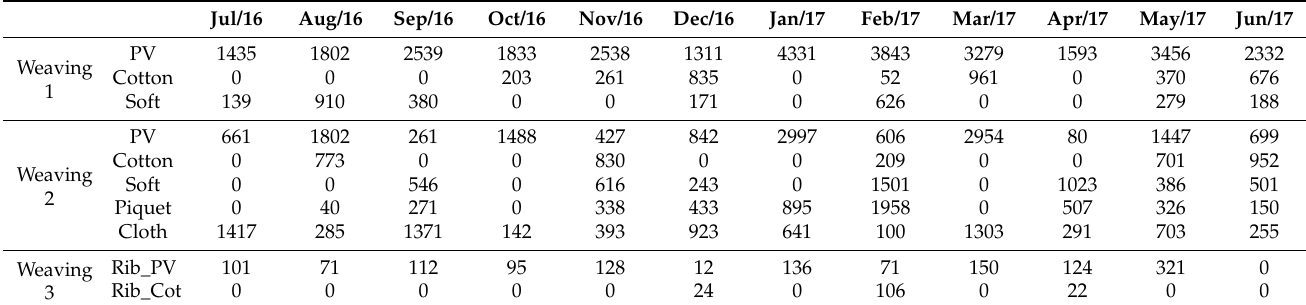
Table 2. Steps for simulation model development.